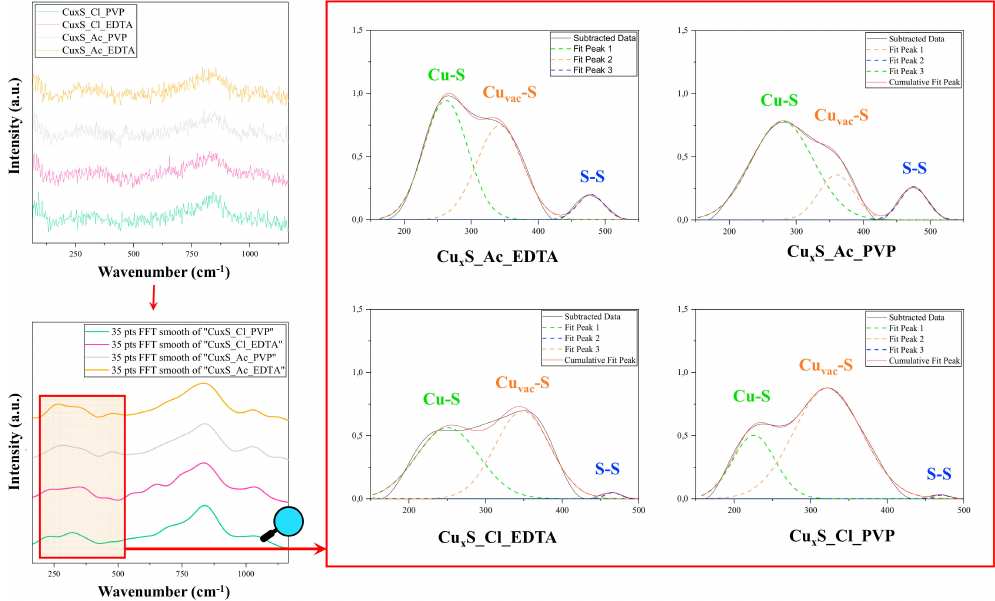
Figure 5. Raman spectra in the 150–1500 cm − 1 region; the 35 pts Fast Fourier Transform FFT smoothed spectra of these samples in the 150–500 cm − 1 region containing the Cu-S, Cu vac -S, and S-S vibration